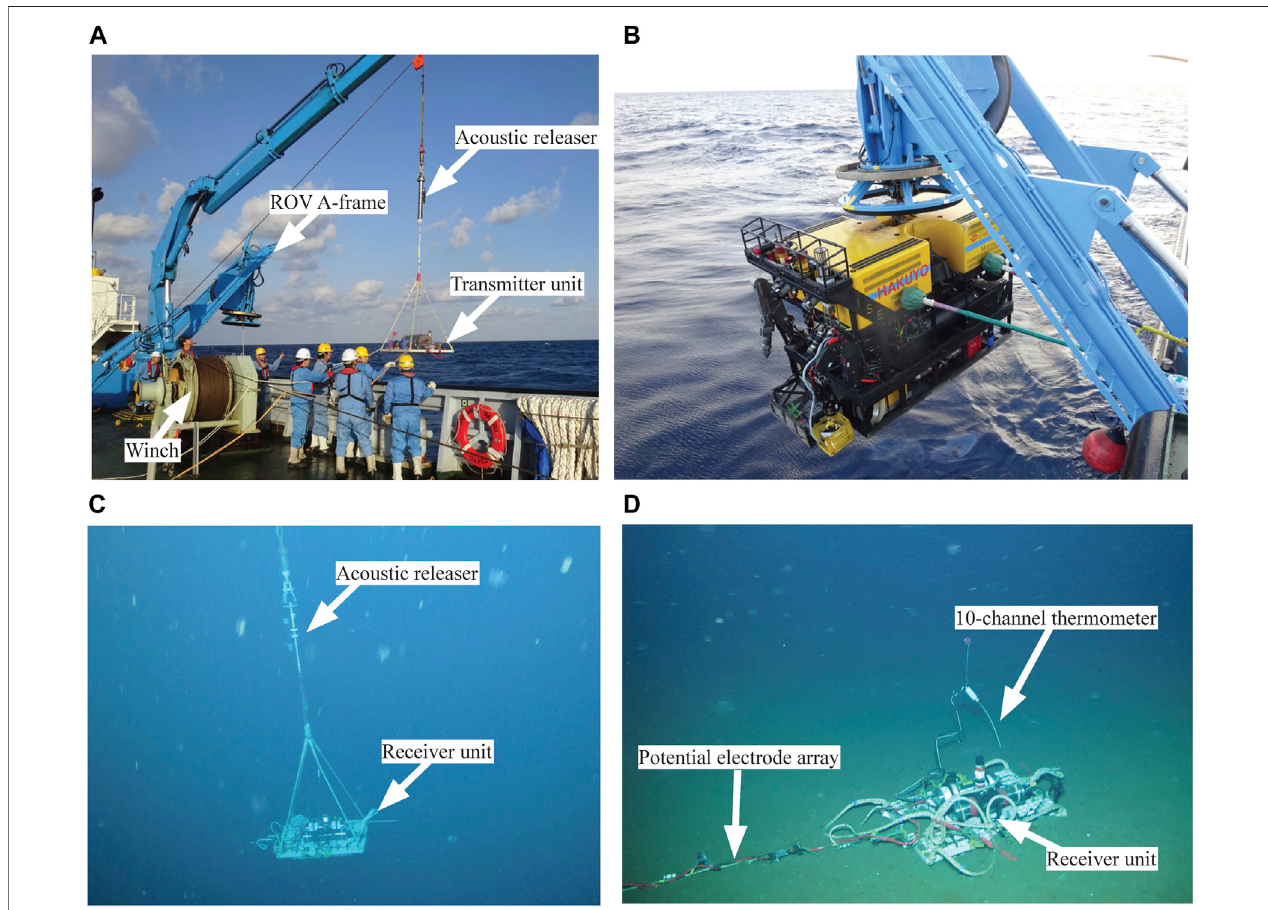
FIGURE 4 | (A) Photograph of the install operation. Each unit was deployed using a winch system. Before installation, the ROV dove and waited for the instrument nearthedeploymentlocation. (B) PhotographoftheROV,HAKUYO2000. (C) Receiverunitdescendingbyawinchsystem. (D) Photographoftheinstalledreceiverunit, the potential electrode array, and the 10-channel